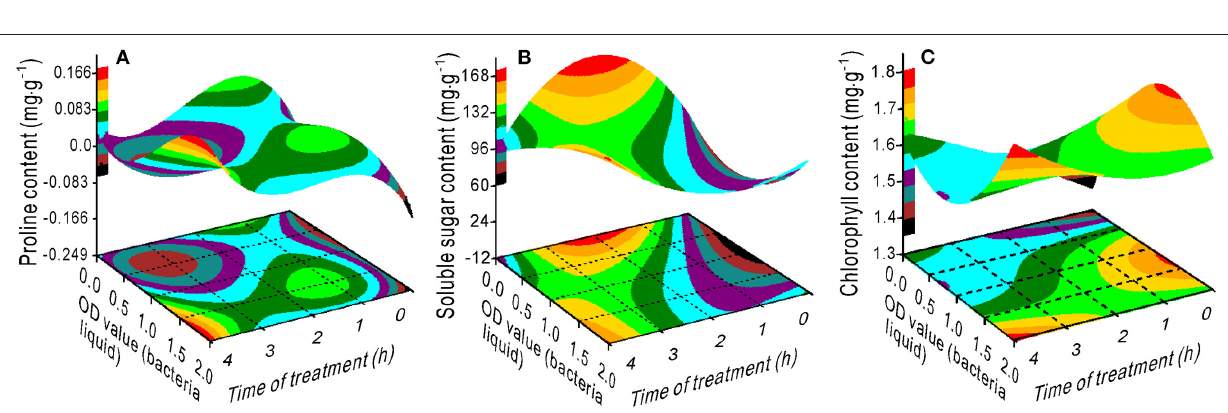
( Supplementary Table 7 ). This may be due to